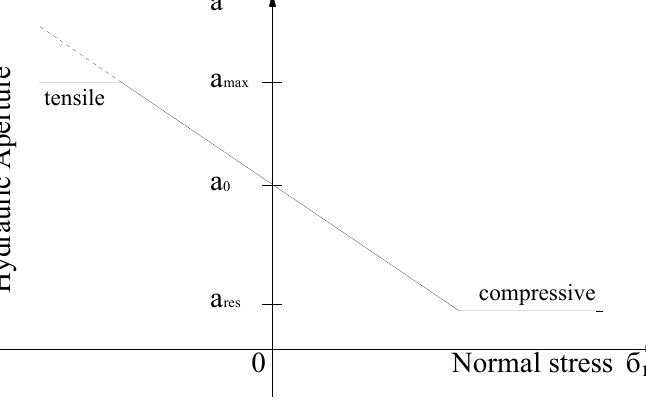
Figure 5. Relationship between the normal stress and hydraulic aperture of the joints.